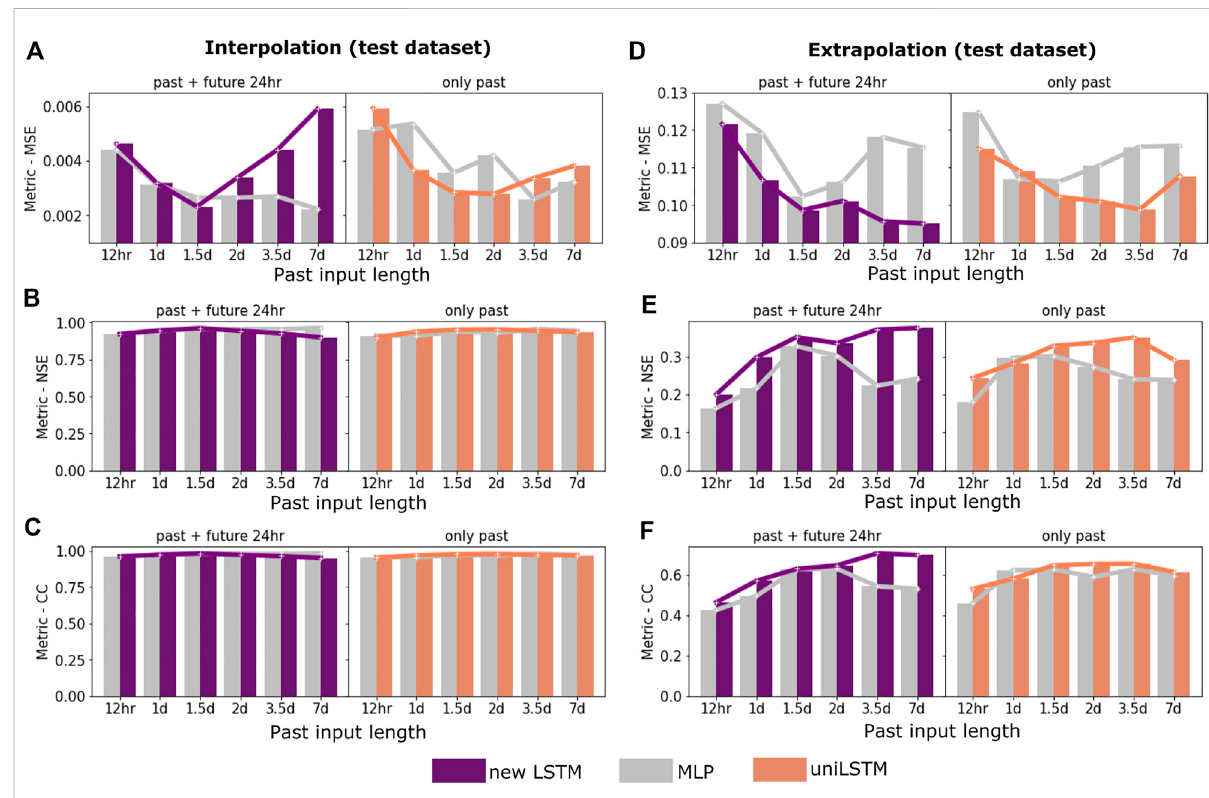
FIGURE 4 Performance of deep learning models for estimating Rsoil. (A-C) model performances on the interpolation scenario test dataset using mean square error (MSE), Nash – Sutcliffe model ef fi ciency coef fi cient (NSE), and correlation coef fi cient (CC). (D-F) model performances on the extrapolationscenariotestdatasetusingMSE,NSE,andCC.Theselectedmetriciscalculatedforallcaseswithdifferentinputtemporalrangesineach subplot (see Table